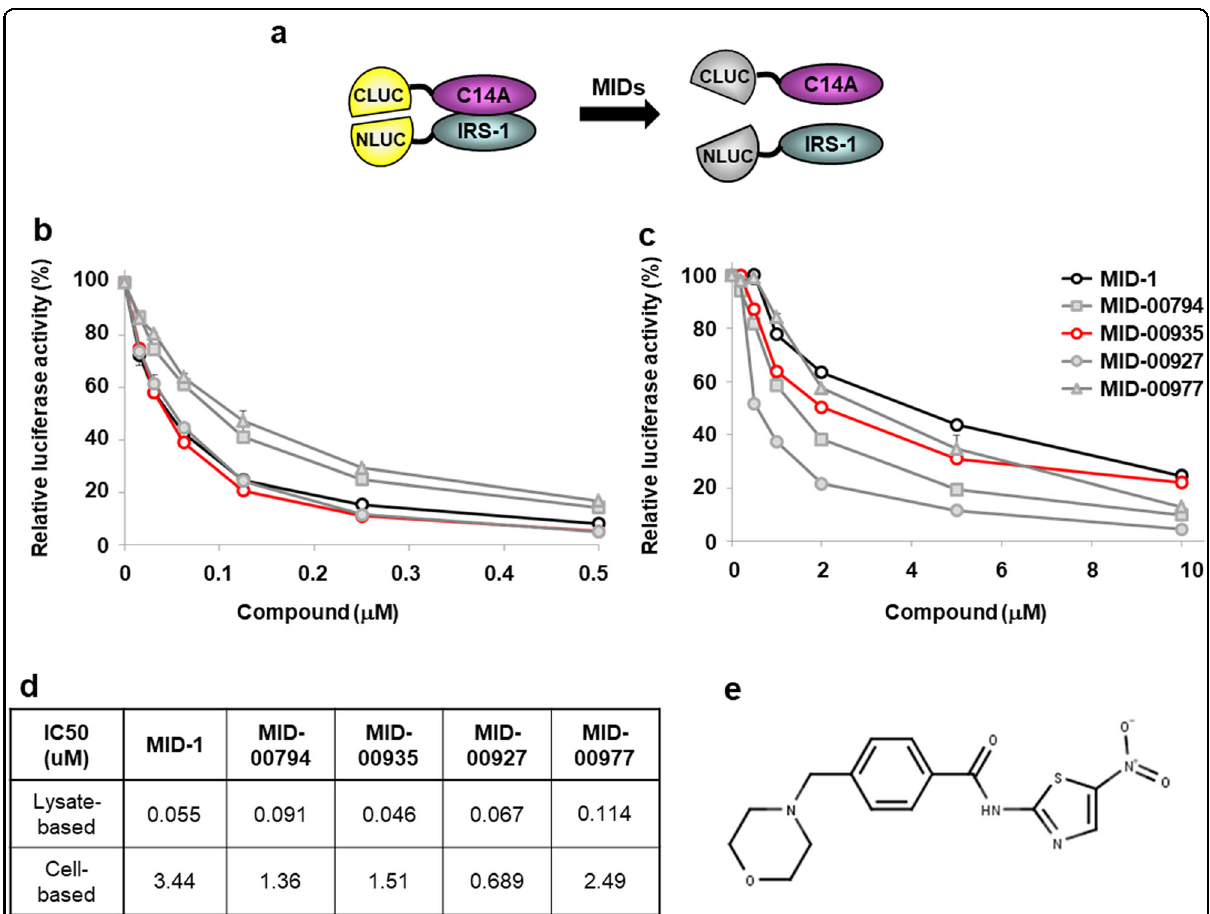
Fig. 1 Screening effective MID derivatives. Scheme of the bimolecular luminescence complementation (BiLC) system for screening MID derivatives. Brie fl y, we used HEK 293 cells expressing a C-terminal luciferase fragment fused with MG53 C14A (CLUC-C14A) and an N-terminal luciferase fragment fused with IRS-1 (NLUC-IRS-1). MID chemical candidates were identi fi ed by reduced luciferase activity ( a ). Luciferase activity was measured in lysate- and cell-based BiLC systems after treatment with four MID-1 derivatives ( b , c ). The IC 50 values for luciferase activity were measured in lysate- and cell-based BiLC systems ( d ). Chemical structure of MID-00935; 4-(morpholinomethyl)-N-(5-nitrothiazol-2-yl) benzamide ( e ). Data represent the means ± SEM, n = 3 per group in b and